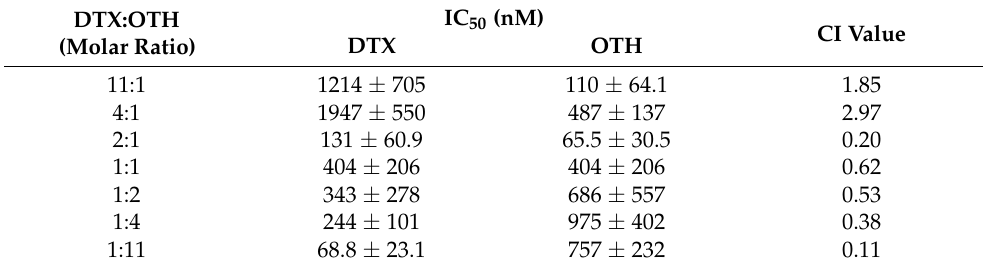
Table 1. CI values of various ratios of docetaxel (DTX) and osthol